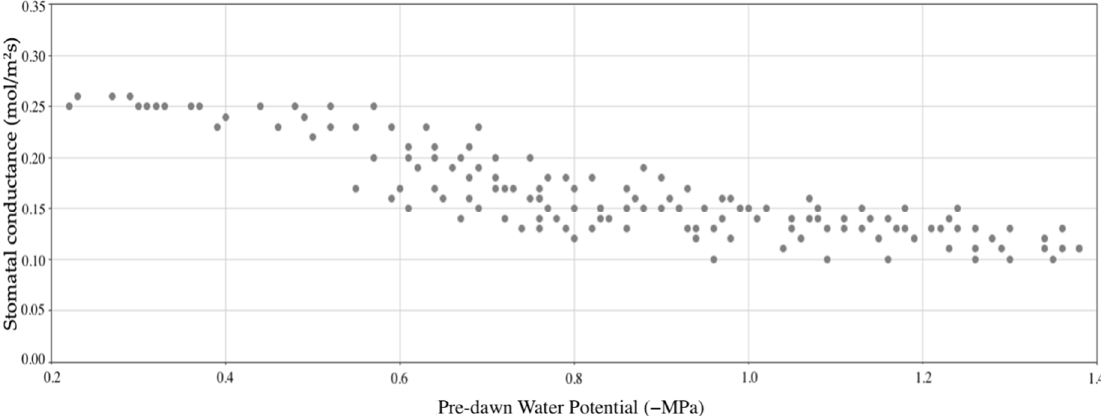
Figure 4. Covariance of pre-dawn water potential and stomatal conductance.